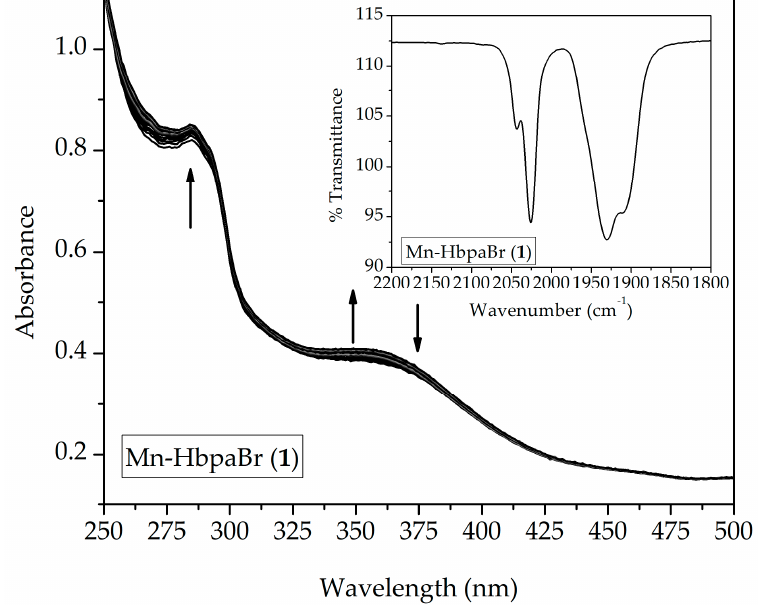
Figure 8. Spectral changes of ( 1 ) acquired through UV-Vis spectroscopy. Spectra were collected in a 1 h interval in CH 3 CN. Sealed quartz cuvettes were kept in the dark during the whole experiment. [( 1 )] = 2.05 × 10 − 4 mol L − 1 . Inset: IR spectra of ( 1 ) (KBr pellets) performed with 100 µL of stock solution (1.00 × 10 − 3 mol L − 1 ) after 24 h in the dark.